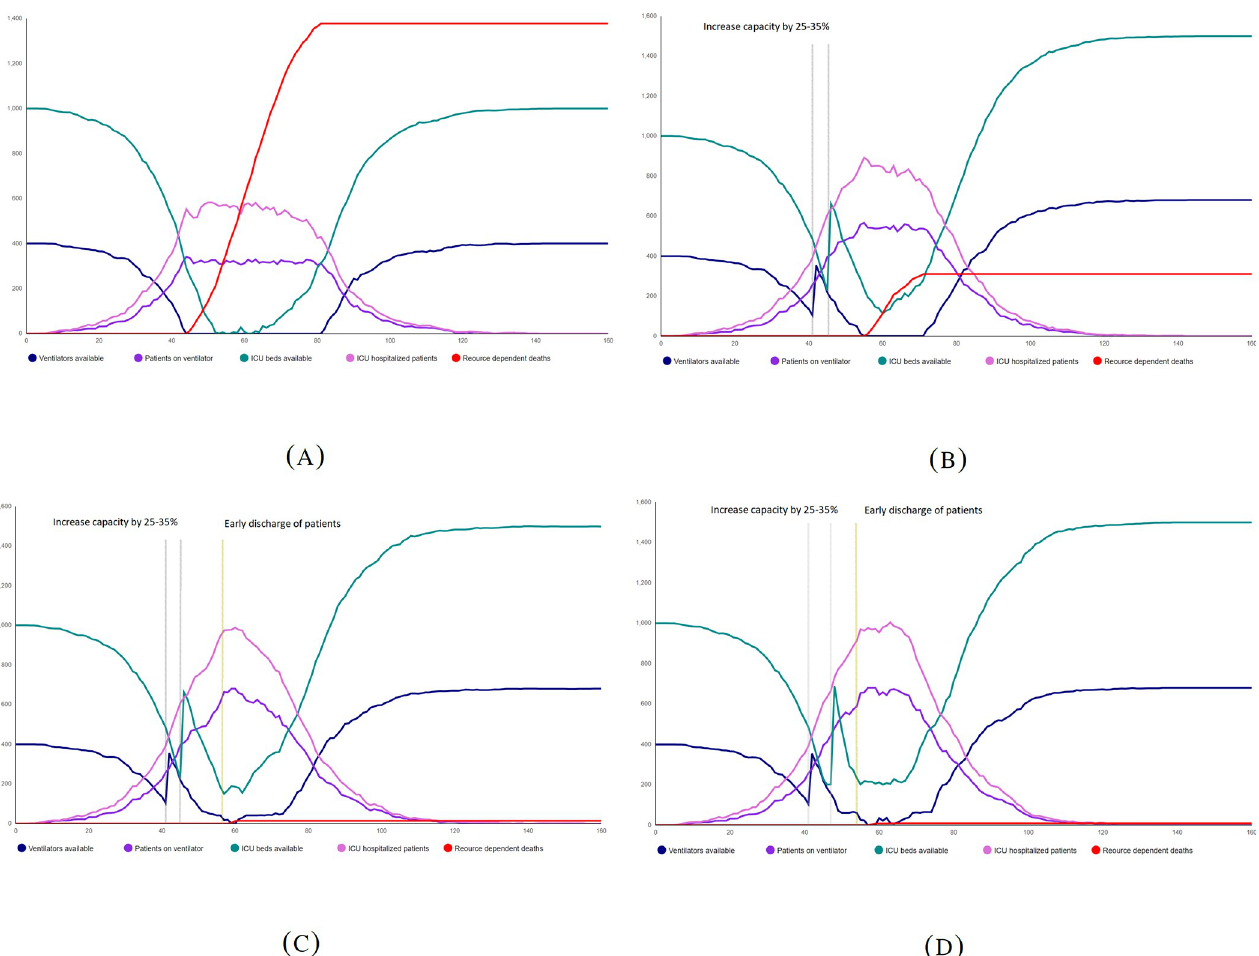
Fig 7. Dynamics of the available resources for HC/ICU beds, ventilators, and the number of resource dependent deaths (A) no management strategy is implemented and therefore the resources are depleted quickly resulting in a high number of deaths (B) 25–35% is added to the resources which reduces the number of resource-dependent deaths significantly (C-D) In addition to the increase of bed and ventilator capacity, early discharge of patients is implemented with two different criteria which further reduces the number of resource-dependent deaths. In (D) the early discharge of ICU patients and patients on ventilator starts when a higher number of resources are still